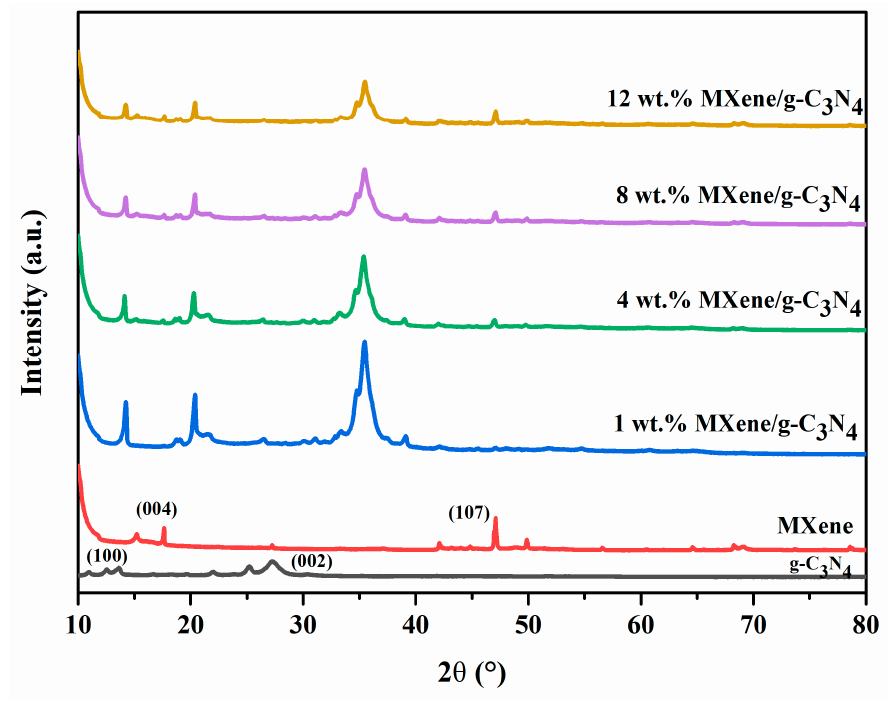
Figure 3. XRD patterns of the as-synthesized MXene/g-C 3 N 4 heterostructure